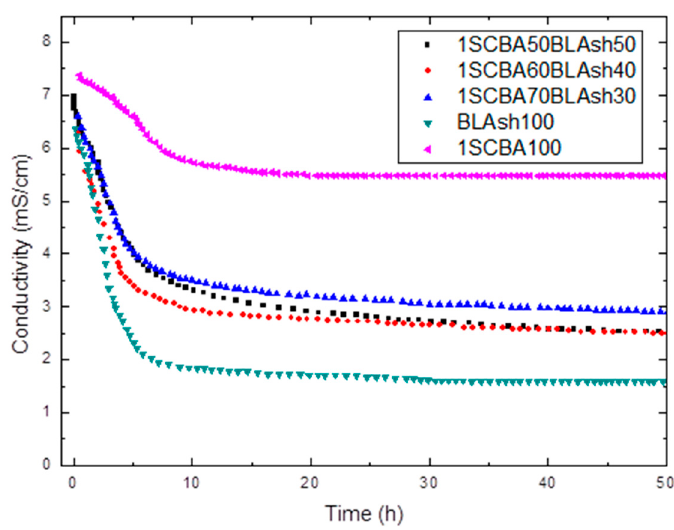
Figure 1. Variation of electrical conductivity with reaction time for binary system 1SCBA + BLAsh.